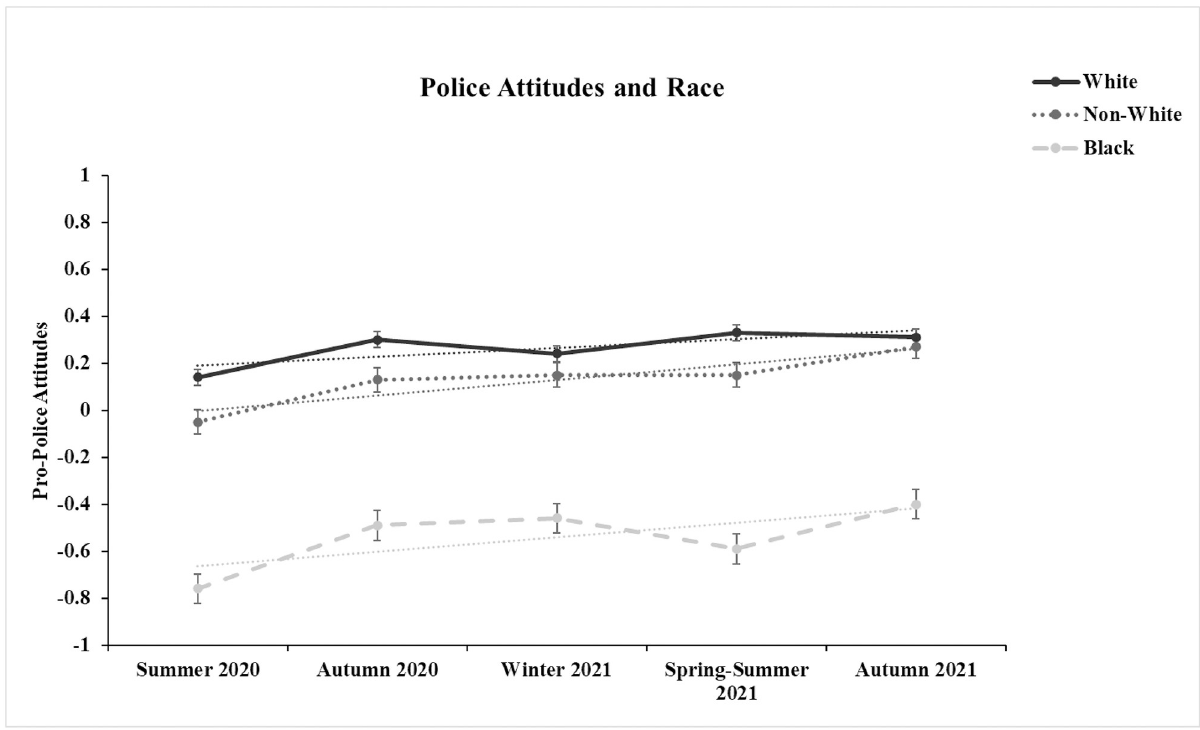
Fig 3. Pro-police attitudes are factor scores derived from the 5-factor confirmatory factor analysis model with items administered at a given time point loading solely on a single-factor at that timepoint. Number of participants across timepoints ranged from 761 to 785 for White, 135 to 145 for Black, and 84 to 115 for other non-White